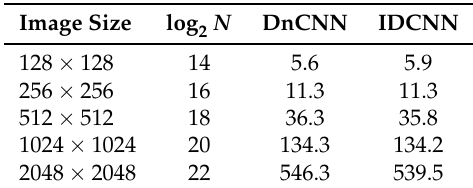
Table 8. Comparison of average execution time (in miliseconds) of the proposed IDCNN detector and DnCNN method on GPU.